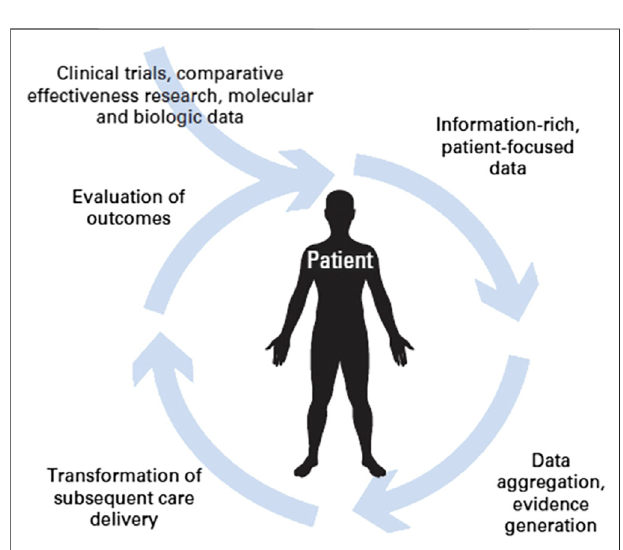
FIGURE 3 | The circular path of Rapid Learning (courtesy of P. Lambin et al.,